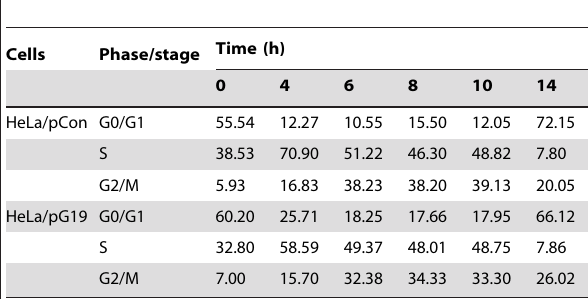
Table 1. GRIM-19 delayed G0/G1